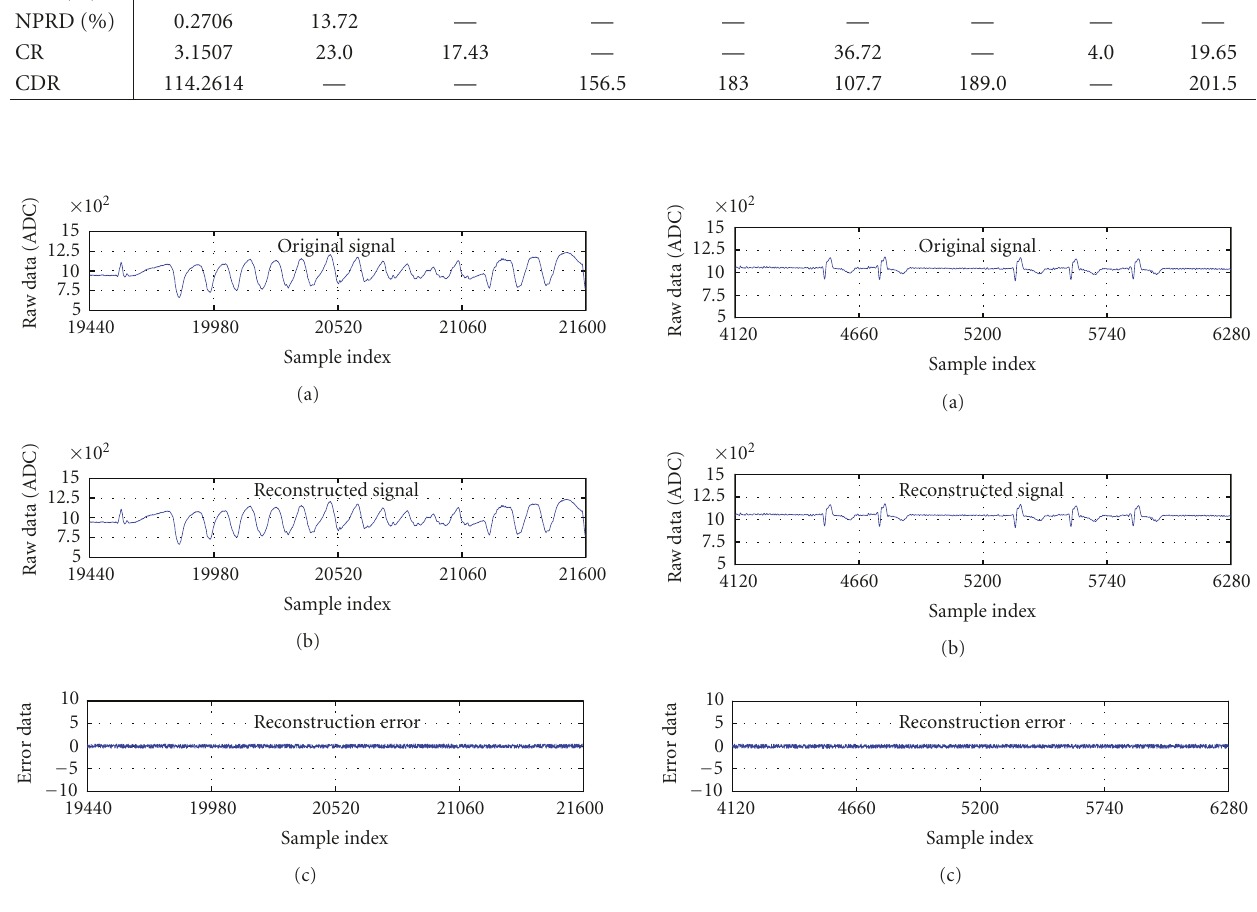
Figure 14: ABT method: original ECG signal along with the re- constructed and residue signals of MIT-BIH ADB record 207MLII . In the reconstructed signal, PRD = 0 . 0287, NPRD = 0 . 3993, SNR = 163 . 1172, RMS = 0 . 2879, CR = 3 . 0583 (PH), BPS = 3 . 9237 (PH), and CDR = 117 . 7111 (PH).